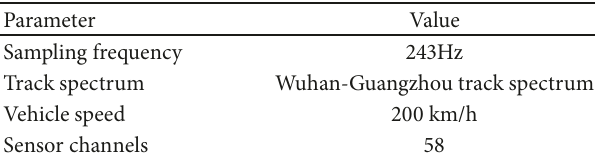
Table 2: The description of parameters of simulation.